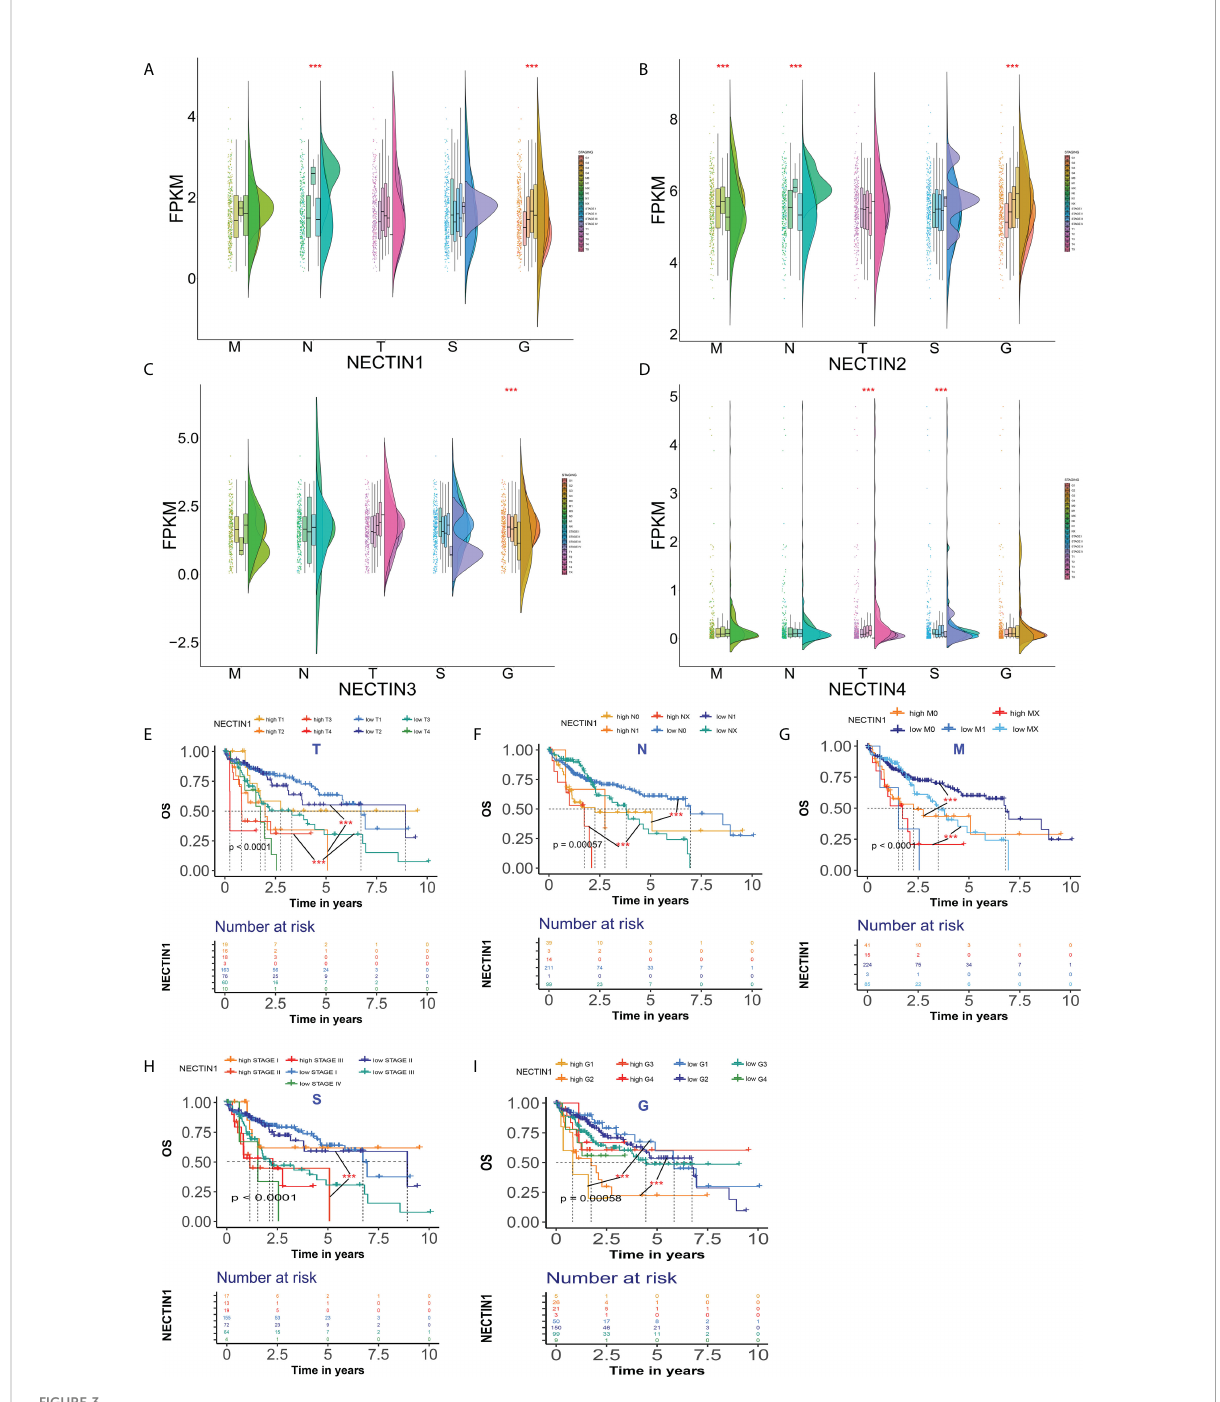
FIGURE 3 Differential expression and prognosis of nectin-1, nectin-2, nectin-3, and nectin-4 in different stages and TNM stages of HCC. (A) Differential expression of nectin-1 in patients with different stages of HCC analyzed by the “ rainclouds ” package. (B) Differential expression of nectin-2 in patients with different stages of HCC analyzed by the “ rainclouds ” package. (C) Differential expression of nectin-3 in patients with different stages of HCC analyzed by the “ rainclouds ” package. (D) Differential expression of nectin-4 in patients with different stages of HCC analyzed by the “ rainclouds ” package. (E) Nectin-1 and prognosis of T-stage of HCC patients. (F) Nectin-1 and prognosis of N-stage of HCC patients. (G) Nectin-1 and prognosis of M-stage of HCC patients. (H) Nectin-1 and prognosis at different stages of HCC patients. (I) Nectin-1 and prognosis at different grades of HCC patients.